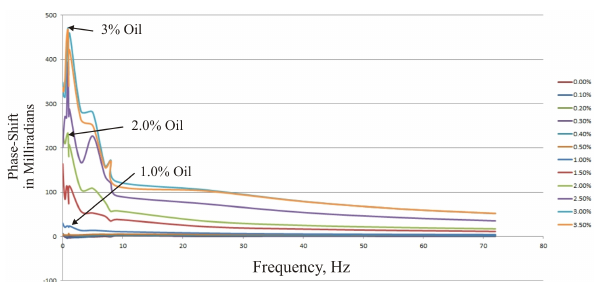
Fig. 4. Normalized distributed capacitance as a phase shift between transmit and receive signals for different multi-viscosity oil percent- ages dispersed in seawater. Phase shift is given in milliradians. For a 3% oil–seawater mix, the phase shift reaches about 460milliradians at 1Hz. To put this in perspective, a large IP anomaly over a dissem- inated sulfide orebody on land, or a core-sample of this material in the laboratory, might reach 20milliradians.